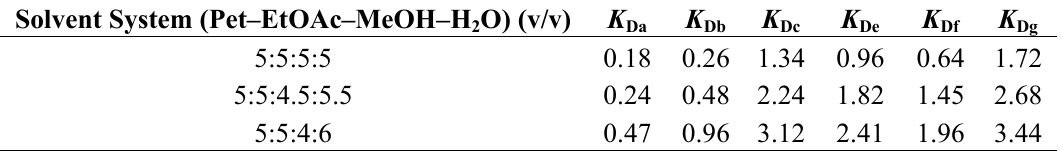
Figure 1. Conventional HSCCC chromatogram of separation crude extracts from Picrasma quassioides ; Conditions: Two-phase solvent system: Pet–EtOAc–MeOH–H